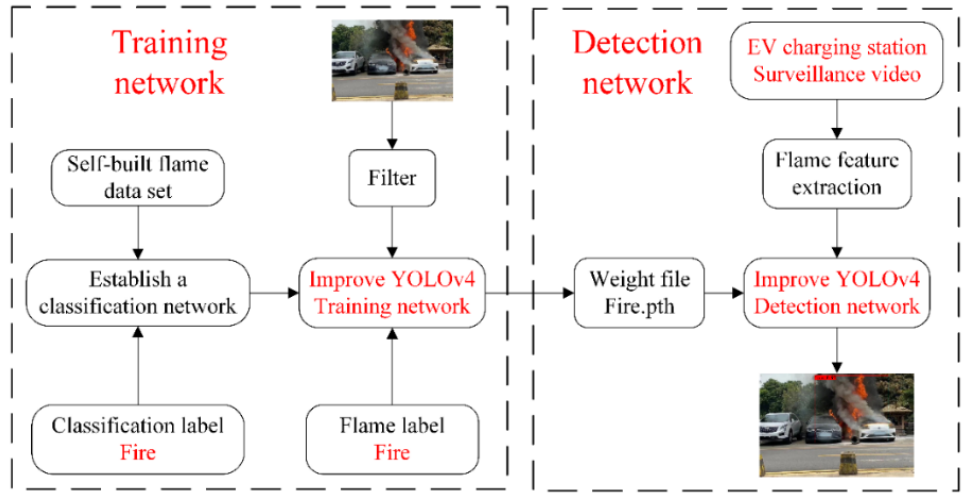
Figure 8. Experimental flow chart.